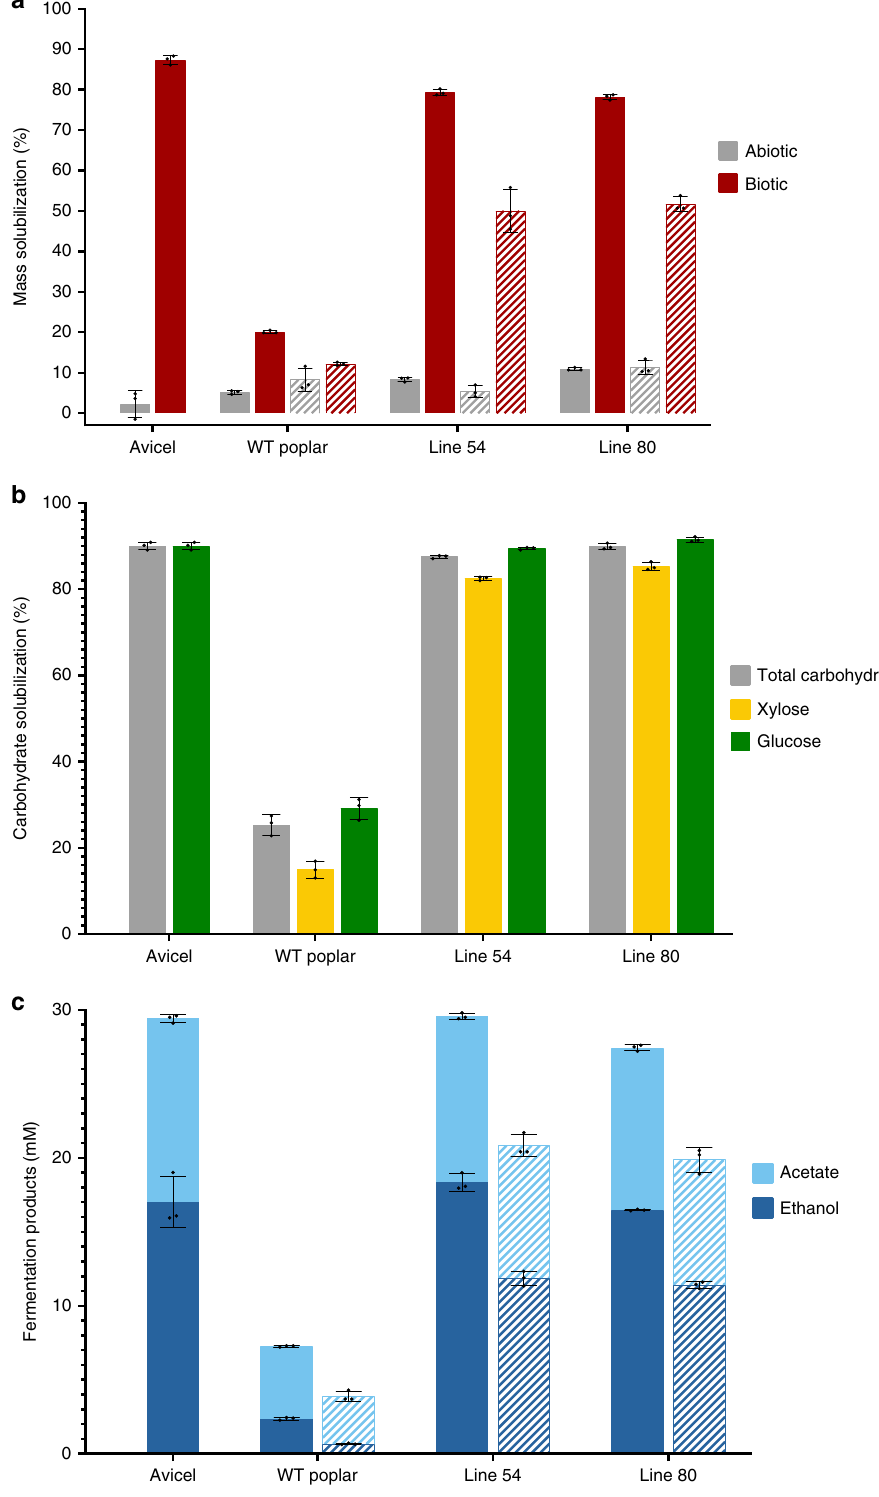
Fig. 1 Solubilization and conversion of poplar by engineered C. bescii . Greenhouse-grown poplar trees were harvested at 6 months, debarked, air dried, and prepared without further processing as approximately 0.5-cm diameter stem segments. A portion of the stem material was milled and sieved to 40/80 mesh size (0.18-0.42 mm), water washed, dried at 50 °C and used at 5 g/L loading. Further stem segments were cut to a weight of 0.25 – 0.30 g and used directly in experiments. Solid bars represent milled biomass, hatched bars represent poplar stem segments. a Total biomass solubilization. b Total carbohydrate solubilization. c C. bescii (MACB 1058) fermentation products resulting from 5 g/L substrate loading. Error bars represent one standard error of three biological replicates. Source data are provided as a Source Data fi